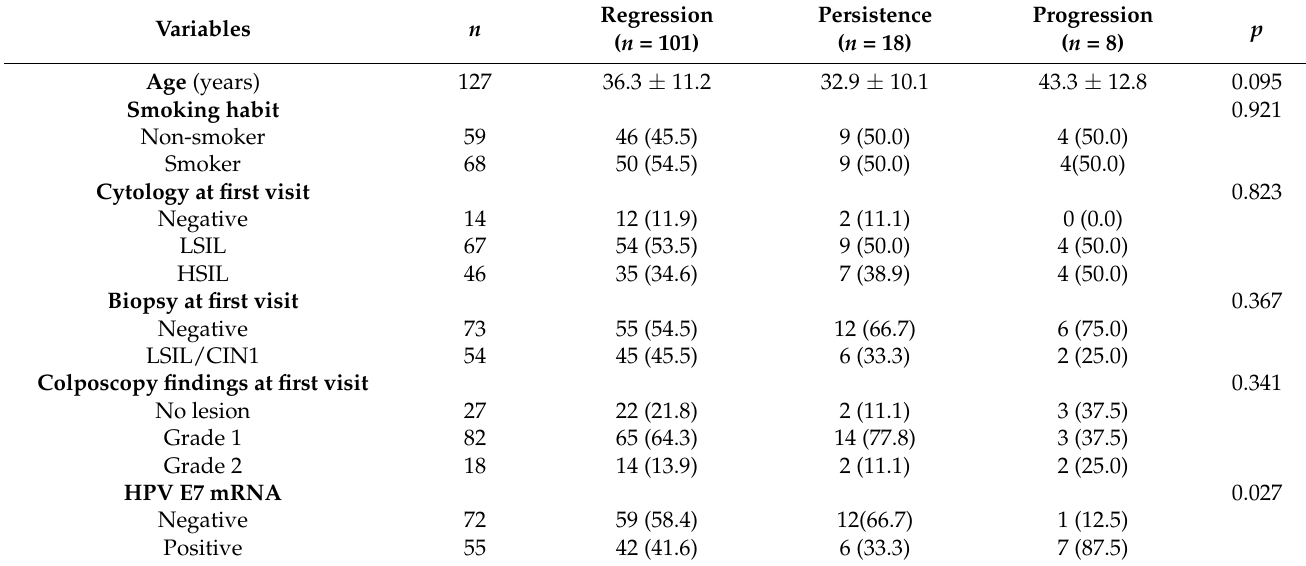
Table 2. Clinical characteristics and results of biomarkers (HPV genotyping and E7 mRNA) at the first visit of the women included in the study according to their final